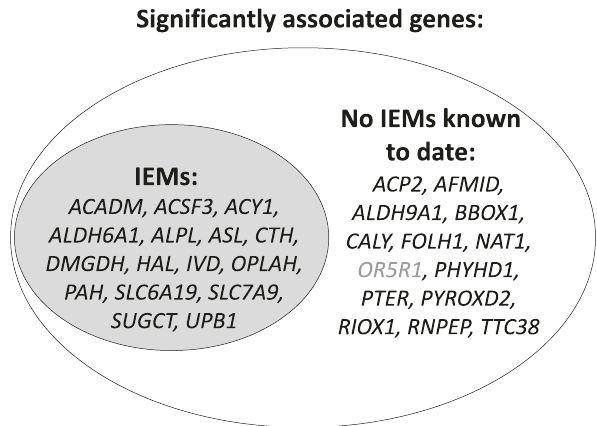
Fig. 4 Venn diagram of the involvement of identi fi ed genes in inborn errors of metabolism (IEMs). All of the known IEMs are recessively inherited. Genes for which no IEMs are yet identi fi ed represent candidate genes in individuals with extreme levels of the implicated metabolites. Gray font is used for OR5R1 because of the extended linkage disequilibrium in the region extending to FOLH1 , which may therefore not represent an independent signal.